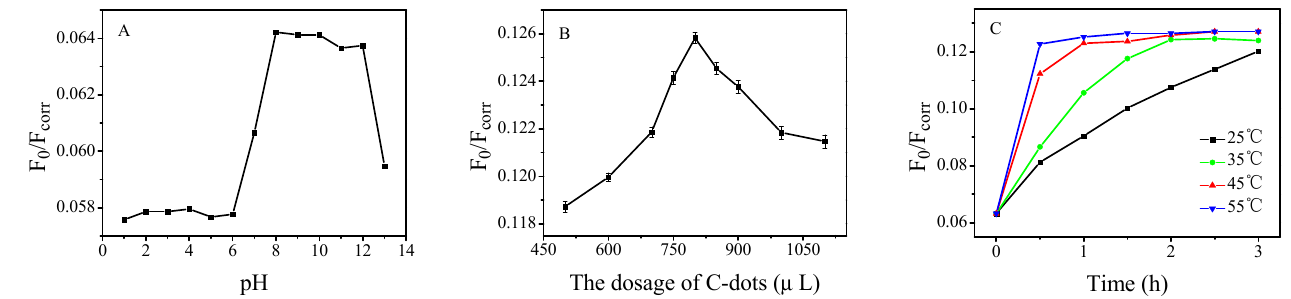
Figure 8. Effects of pH of phosphate buffer solution (PBS) ( A ), amount of C-dots ( B ), synthetic time and temperature ( C ) on fluorescence quenching efficiency of the C-dots-DA system. F 0 and F corr are the fluorescence intensity of C-dots in the absence and presence of DA, respectively. Conditions: PB, 30 mM; DA, 37.5 μ M.